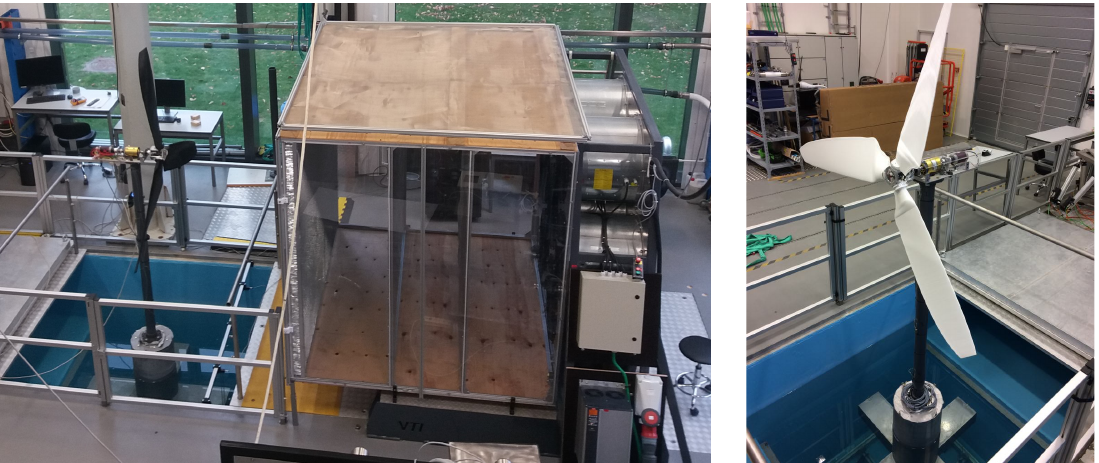
Figure 4. Offshore laboratory at AAU Esbjerg where a wave tank with a 1:35 scaled model of a 5 MW wind turbine on a TLP is installed and wind generator wind a wind filter in front of it.